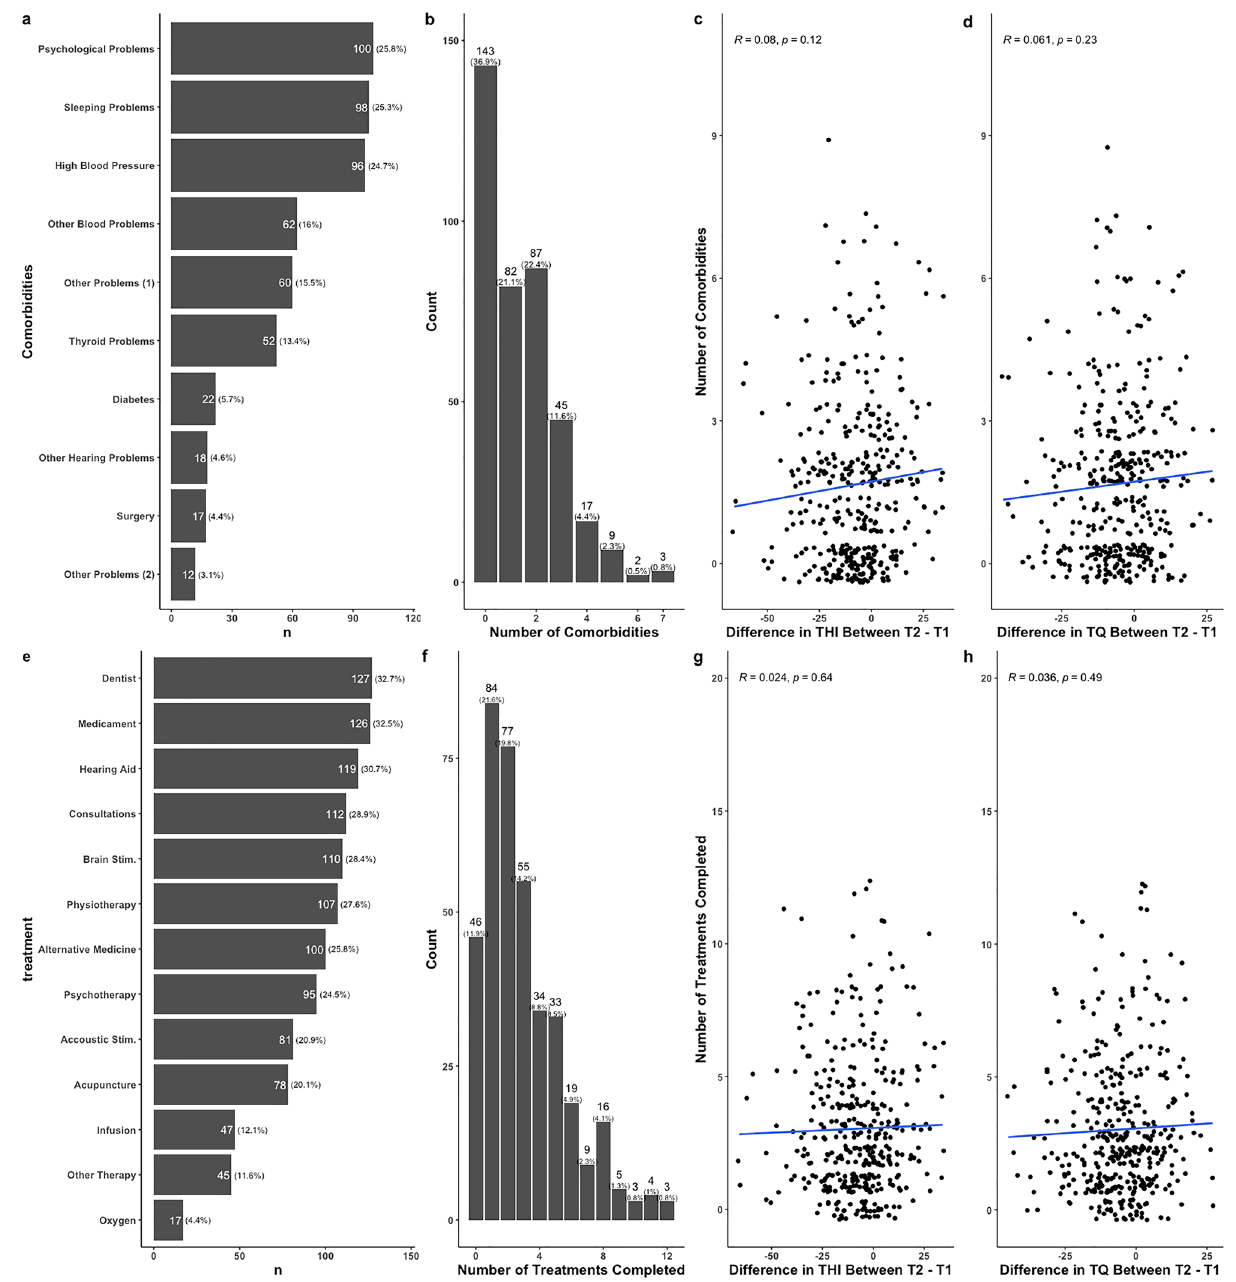
Figure 1. Relation between the number of comorbidities experienced, treatments tried, THI and TQ over